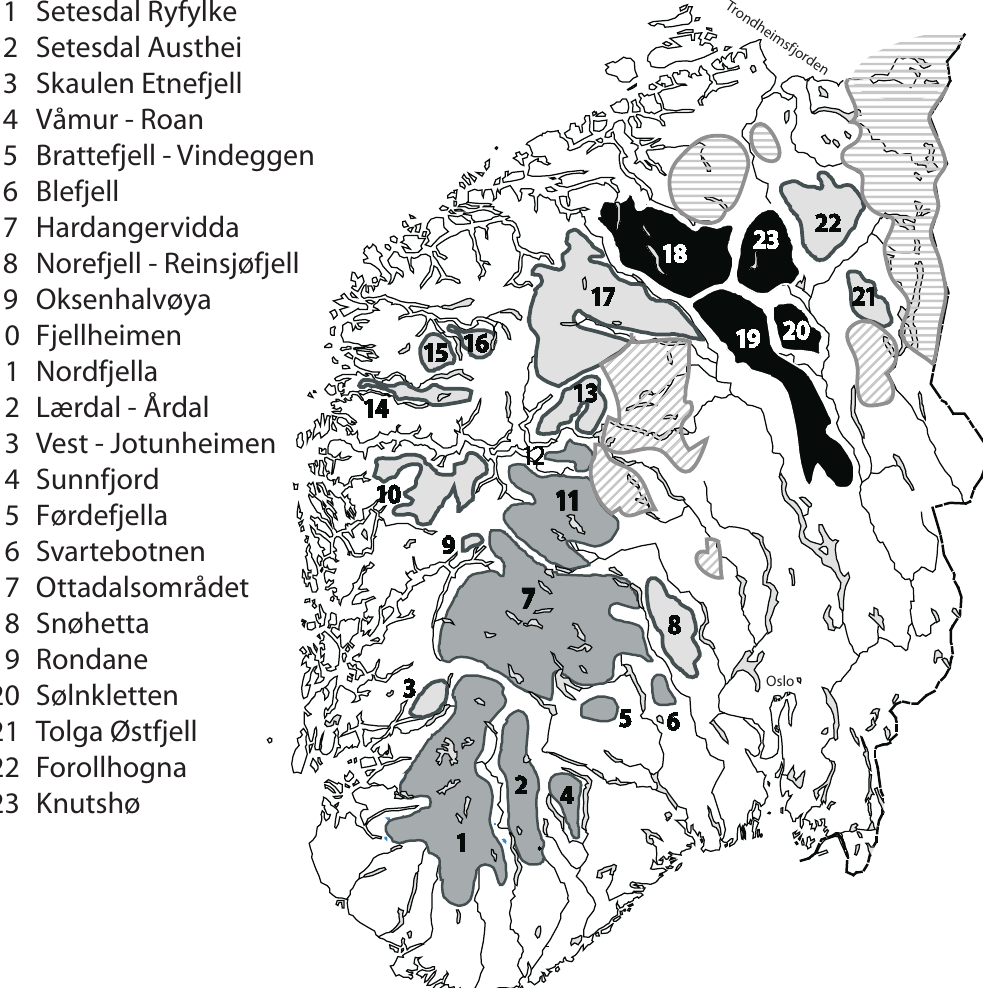
Sami reindeer herding districts Norwegian reindeer herding